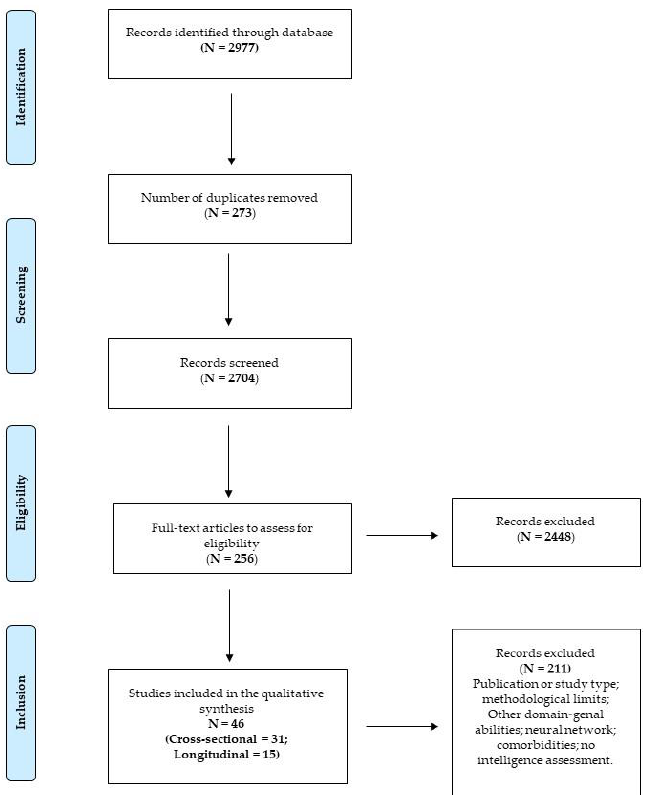
Figure 2. PRISMA flow chart of the selected studies on mathematical difficulties and cognitive func- tioning.